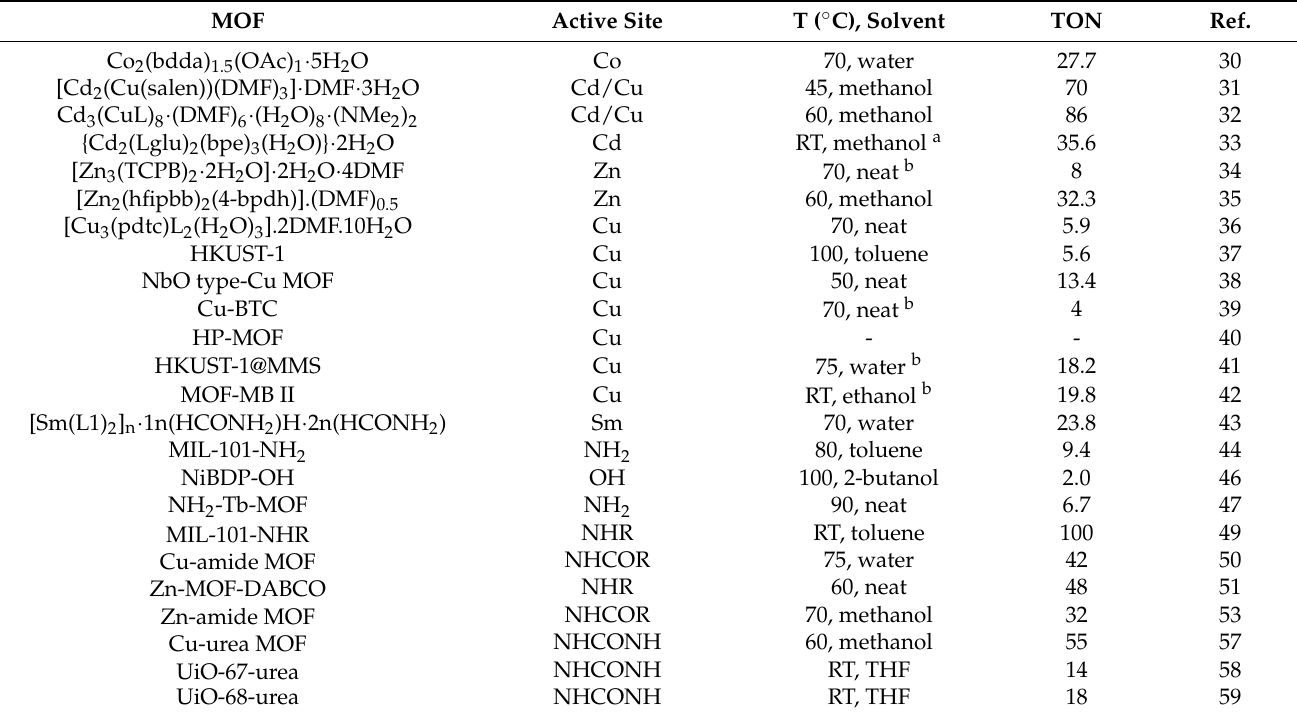
Table 1. Catalytic performance of the MOFs employed as solid catalysts in the Henry reaction between benzaldehyde and nitromethane. MOF Active Site T ( ◦ C), Solvent TON